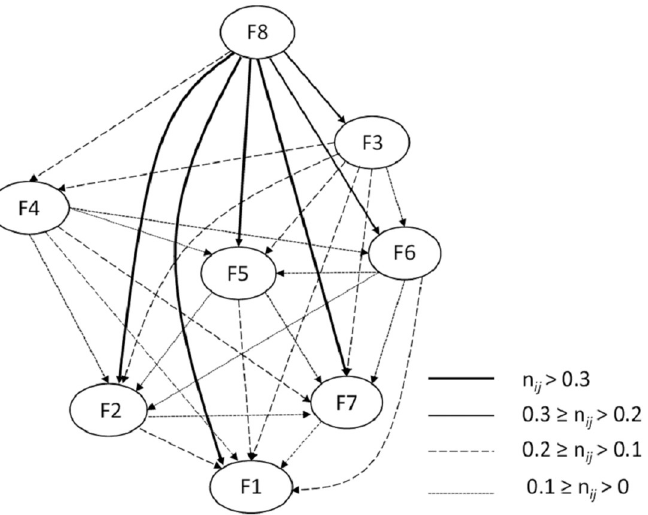
Fig 6. Map of the total net influence. Graph arcs indicate a factor under the influence of another factor and the type of line—total influence intensity—the value range for element n ij in the NeT matrix.